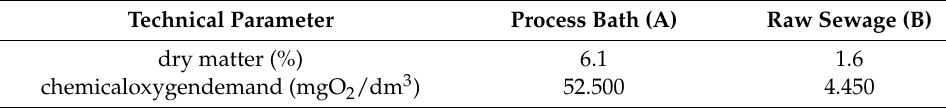
Table 6. Parameters of the liquid